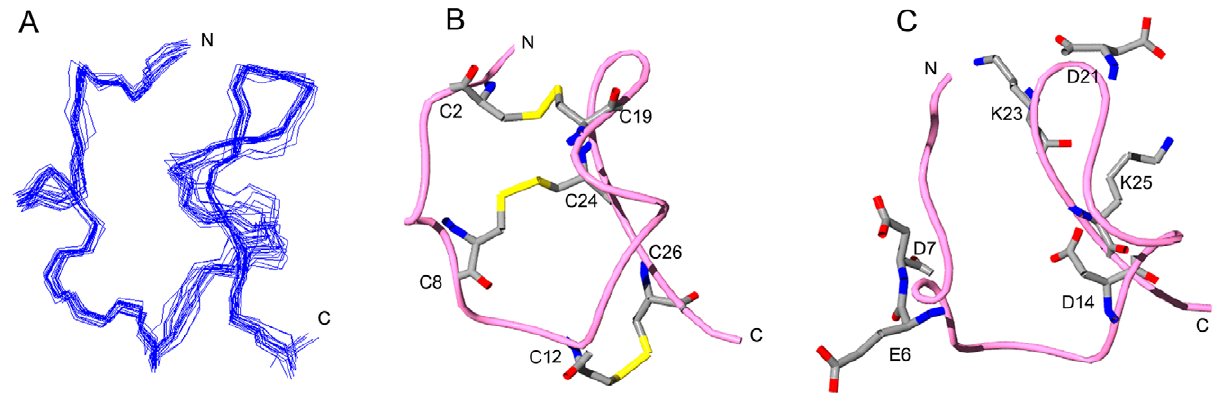
Figure 7. Structure of ImKTx104 by 1 H, 15 N-NMR. (A) Superposition of the backbone atoms of the best 20 structures, fitted to residues 1 to 27; (B) Ribbon representation of the structure closest to the mean with the disulfide bridges shown; (C) Ribbon representation of the structure with the acidic and basic residues shown.